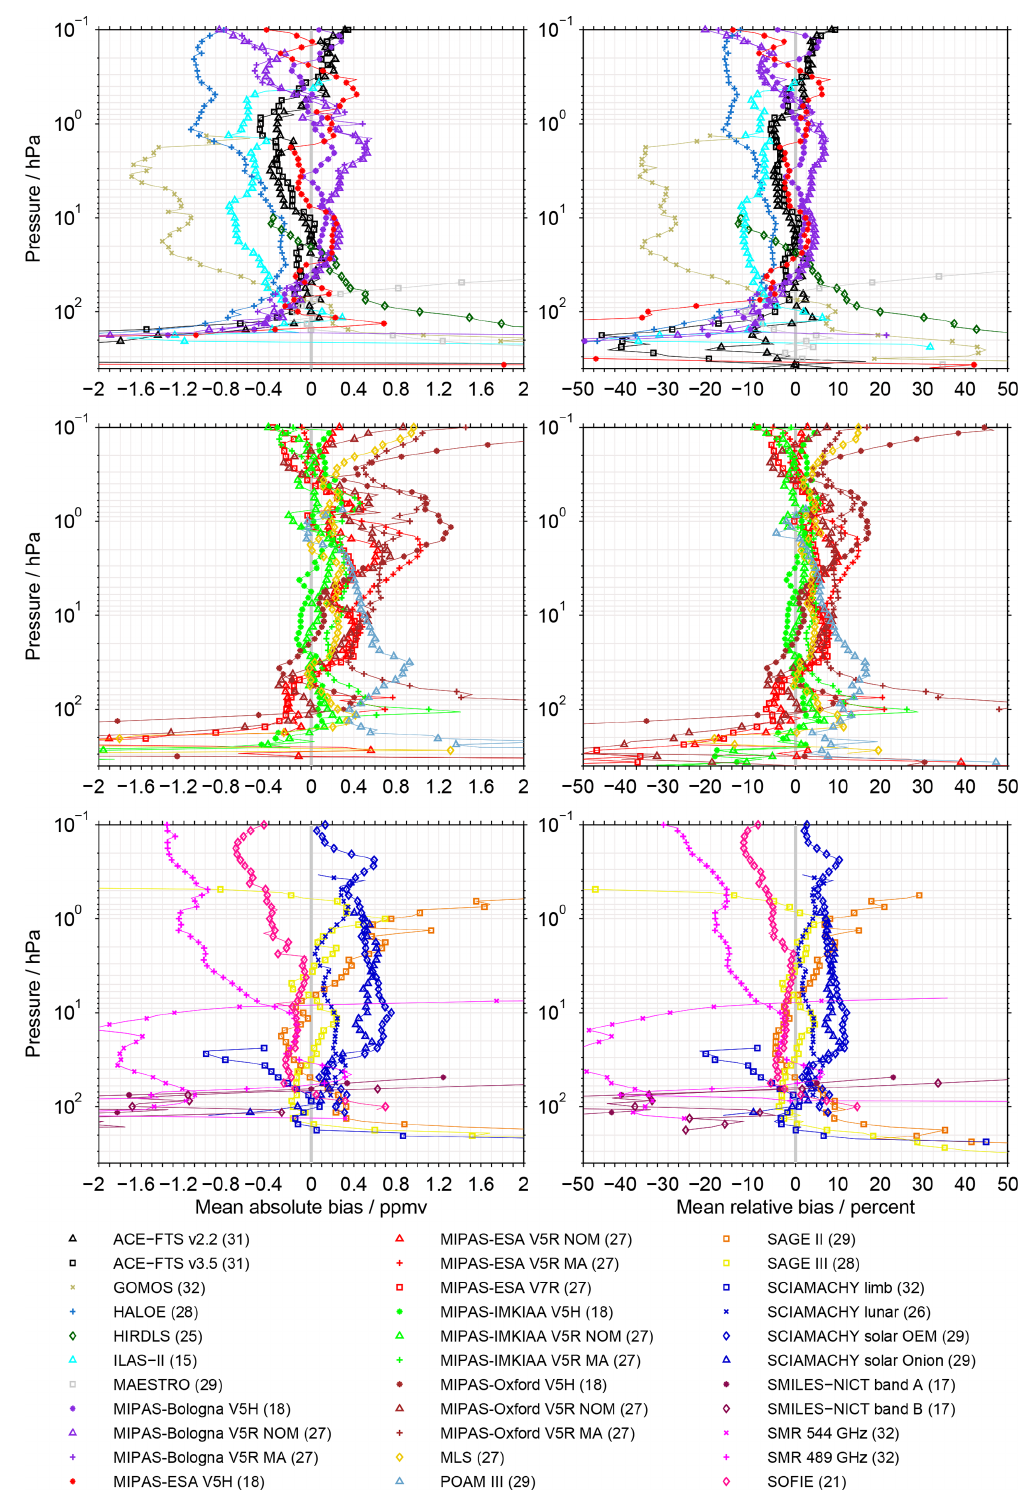
Figure 8. A bias summary for all data sets. This summary is based on the comparisons that considers coincidences during all seasons and at all latitudes and takes into account the aggregation of the MIPAS results (see Sect. 3.5). Absolute biases are shown in the left column, relative biases in the right column. For the sake of better visibility the results have been split among three rows. The separation is also reflected by the legend columns. In the legend the number of comparisons contributing to the summary for the individual data sets is also